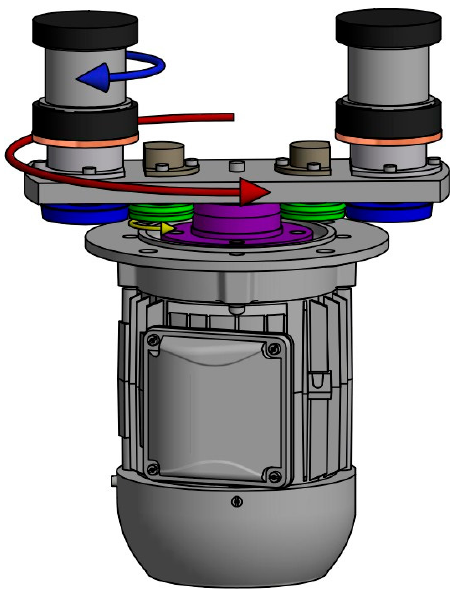
Figure 4. Sketch of the core elements of the designed planetary ball mill.